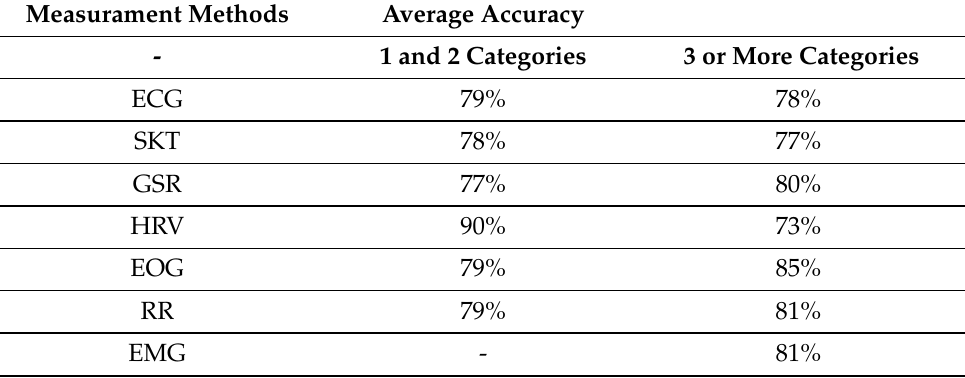
Table 1. State-of-the-art recognition rates obtained by analyzing electrocardiogram (ECG), SKT, Galvanic Skin Response (GSR), Heart Rate Variability (HRV), Respiration Rate Analysis (RR), Skin Temperature Measurements (SKT), Electromyogram (EMG), Electrooculography (EOG) presented in [32].